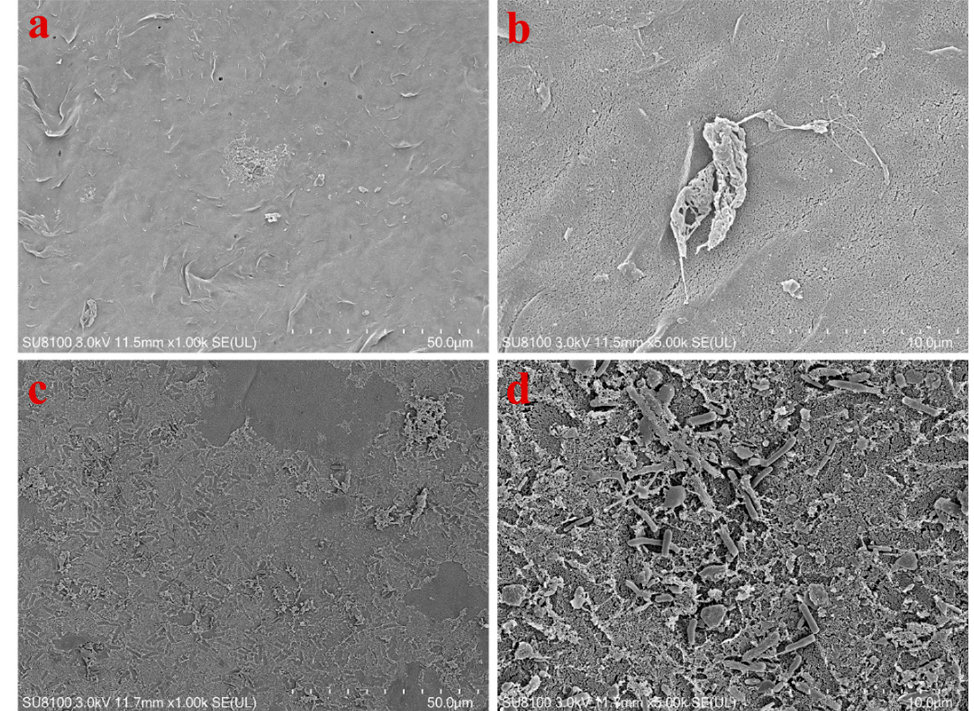
Figure 6. FESEM images of the surface of MF membranes. ( a , b ) Images of MF membrane fouled by Syn 7942 under a feed pressure of 1.00 bar; ( c , d ) images of UF membrane fouled by Syn 7942 under a feed pressure of 1.00 bar.